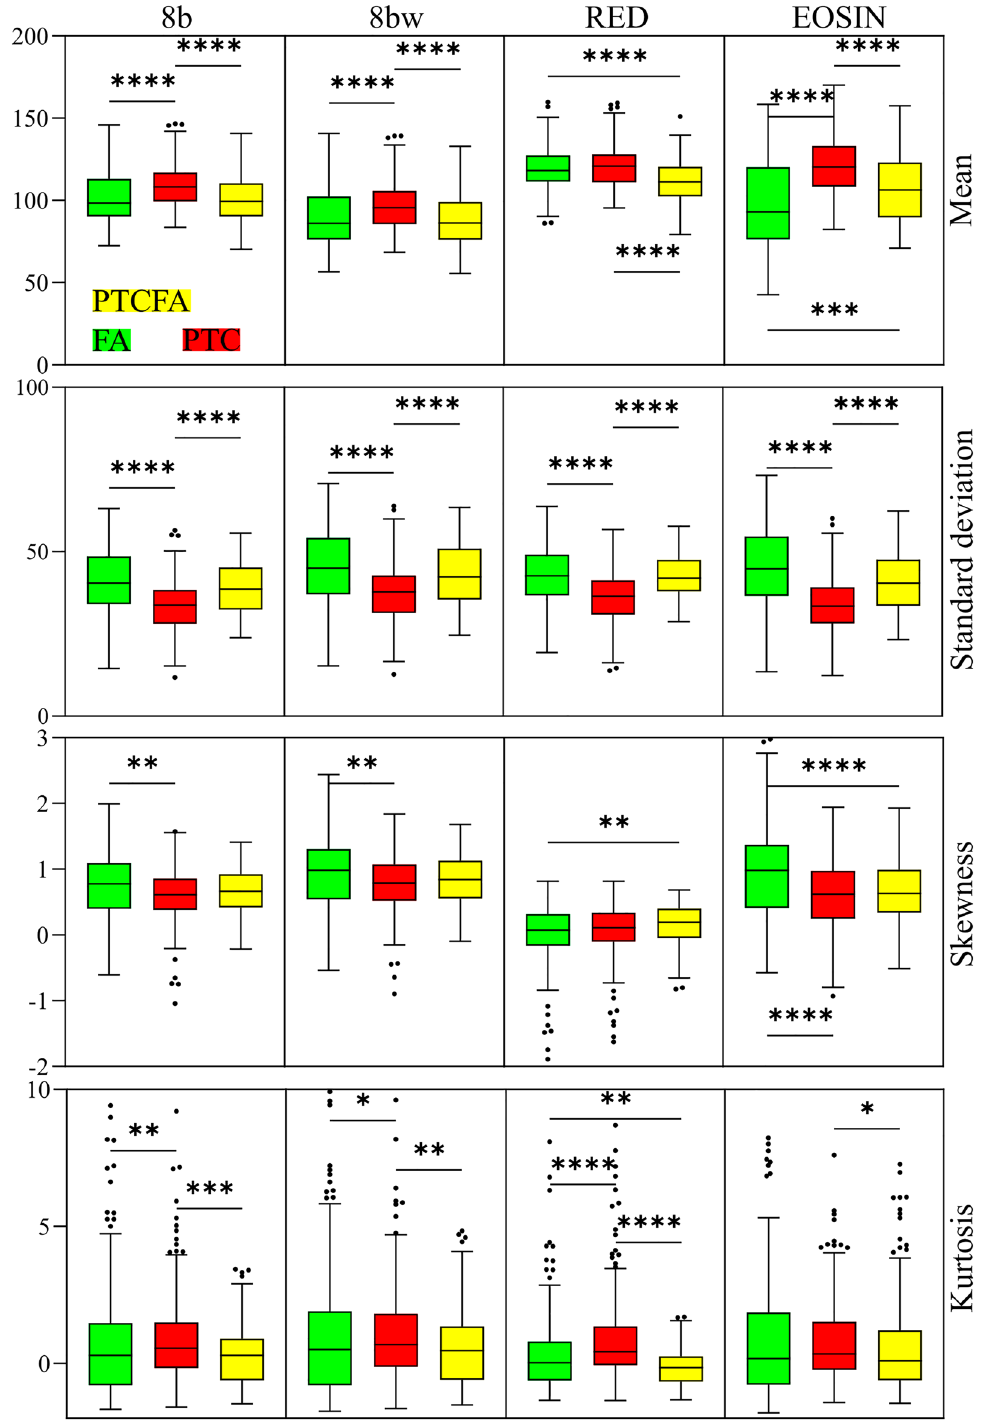
Figure 4. Statistical analysis for the case of histogram parameters extracted from the 1024 × 1024 pixels image tiles. (* p < 0.05, ** p < 0.01, *** p < 0.001, **** p <